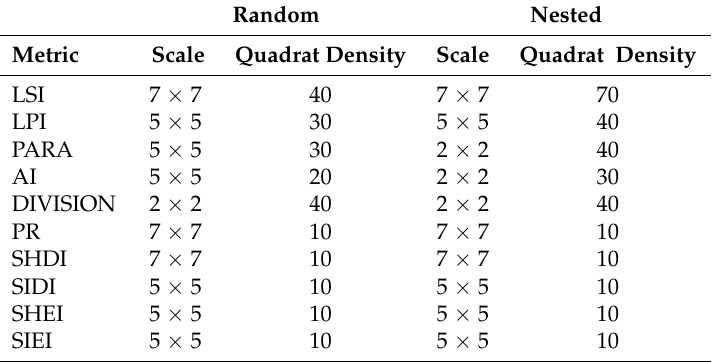
Table 5. Suggested sampling designs for the seascape metrics considered in this study for the case study area of Ponta do Ouro (Mozambique). The metrics reported include: Landscape Shape Index (LSI), Large Patch Index (LPI), Perimeter Area Ratio (PARA), Aggregation Index (AI), Division Index (DIVISION), Patch Richness (PR), Shannon’s Diversity Index (SHDI), Simpson’s Diversity Index (SIDI), Shannon’s Evenness Index (SHEI) and Simpson’s Evenness Index (SIEI). Random Nested Metric Scale Quadrat Density Scale Quadrat